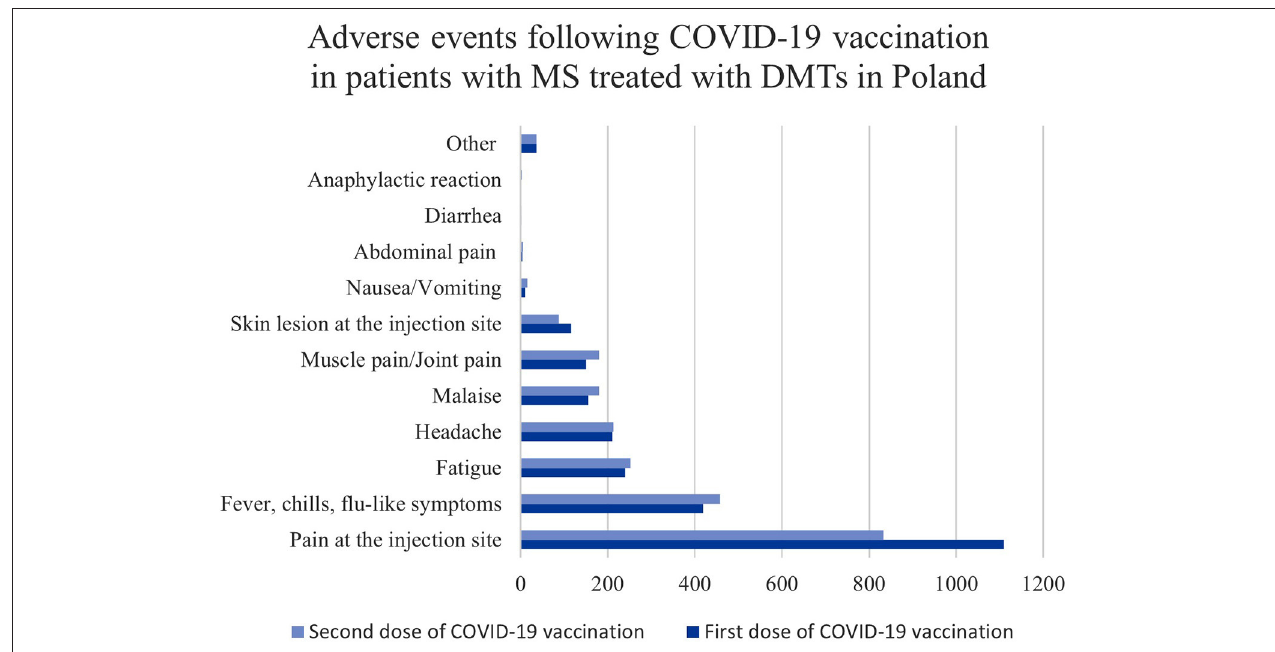
FIGURE 1 | The distribution of adverse events reported in individuals with MS treated with DMTs in Poland.